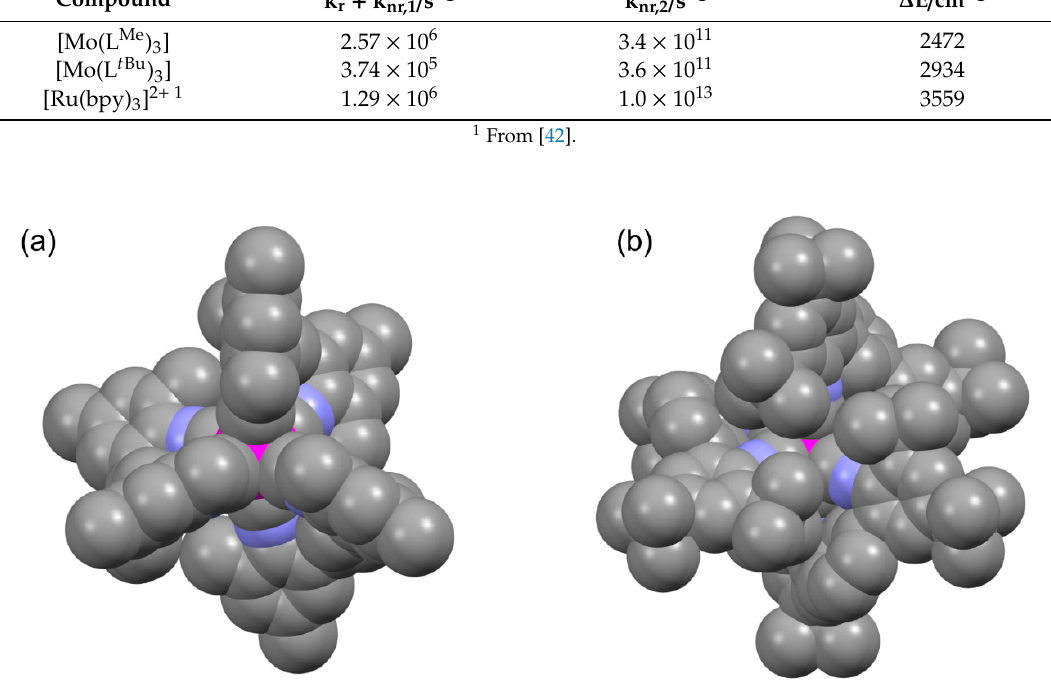
Figure 5. Space-filling representations of X-ray crystal structures of ( a ) [Mo(L Me ) 3 ] and ( b ) [Cr(L t Bu ) 3 ] [24,25]. An X-ray structure of [Mo(L t Bu ) 3 ] is not available; hence, the Cr 0 structure in ( b ) is used for comparison with [Mo(L Me ) 3 ].